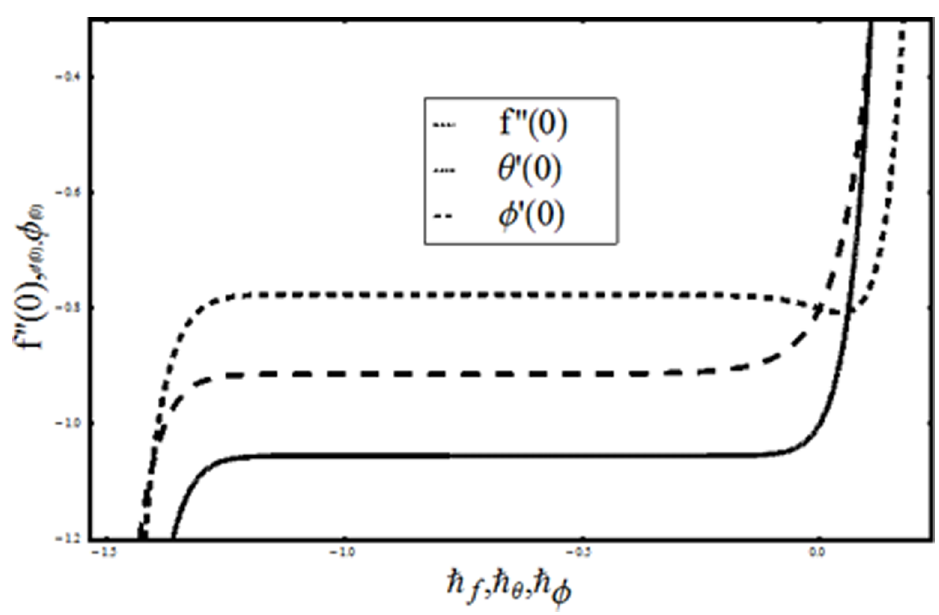
Figure 2. h (cid:2) { curves of functions f ( g ), h ( g ) and w ( g ) at 17th-order of deformations when M ~ 0 : 6, b ~ 0 : 4 ~ Rd , l 1 ~ 0 : 5, l ~ 0 : 3 ~ N , Pr ~ 1 : 2, S ~ 0 : 2 ~ S (cid:2) , Sc ~ 1 : 0 :